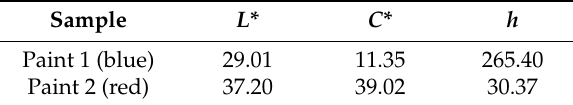
Table 1. Initial L * C * h * of Paint 1 and Paint 2.